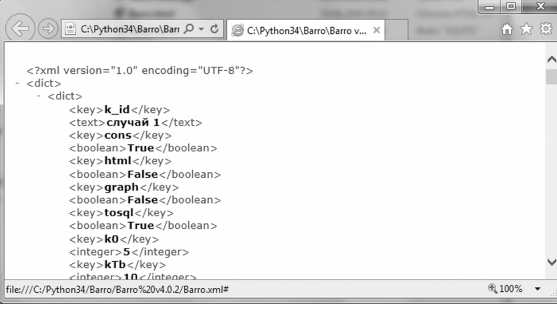
Fig. 3. Prepared XML